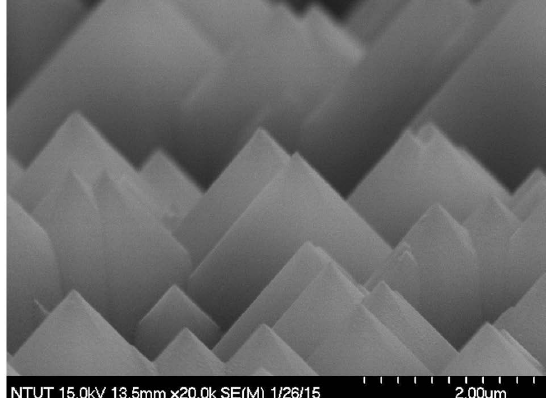
Figure 1. Scanning electron microscopy (SEM) image showing the surface of crystalline-silicon (c-Si) wafer after etching by being dipped into a solution of H 2 O/KOH/IPA